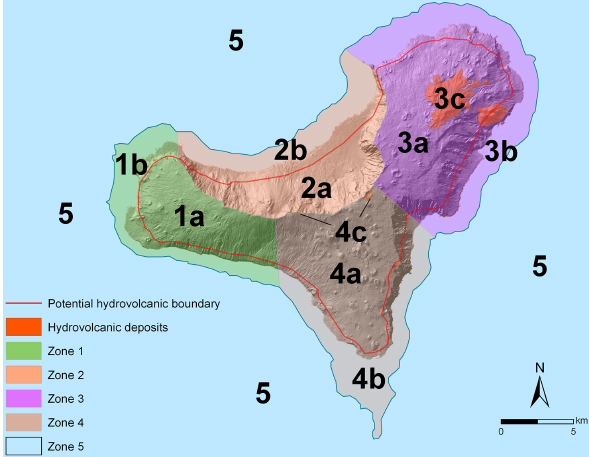
Figure 3. Sectors and subsectors defined on El Hierro. Sectors 1–4 show onshore division while sector 5 represents the offshore area. The division is based on differences in structural patterns, spatial probability of hosting new vents and expected hazards. Subsec- tors a–c take into account the potential occurrence of hydrovolcanic